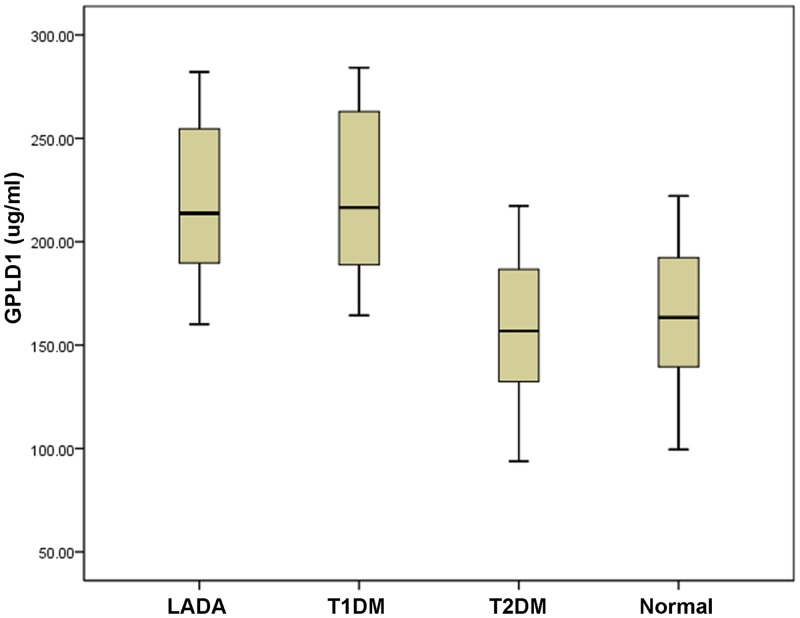
ELISA analysis of the concentration of GPLD1 among the four cohorts.No significant difference in GPLD1 expression was observed between the LADA and ‘classic’ type 1 diabetes cohorts (P >0.05); however, there were significant differences between the LADA cohort and the type 2 diabetes and normal control cohorts (P<0.05).